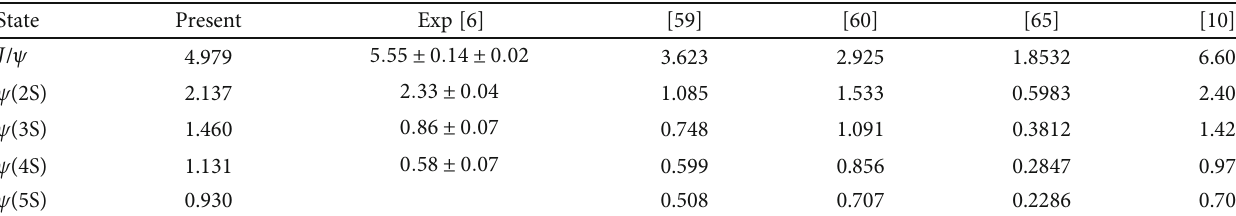
Table 4: Leptonic decay widths (in keV).